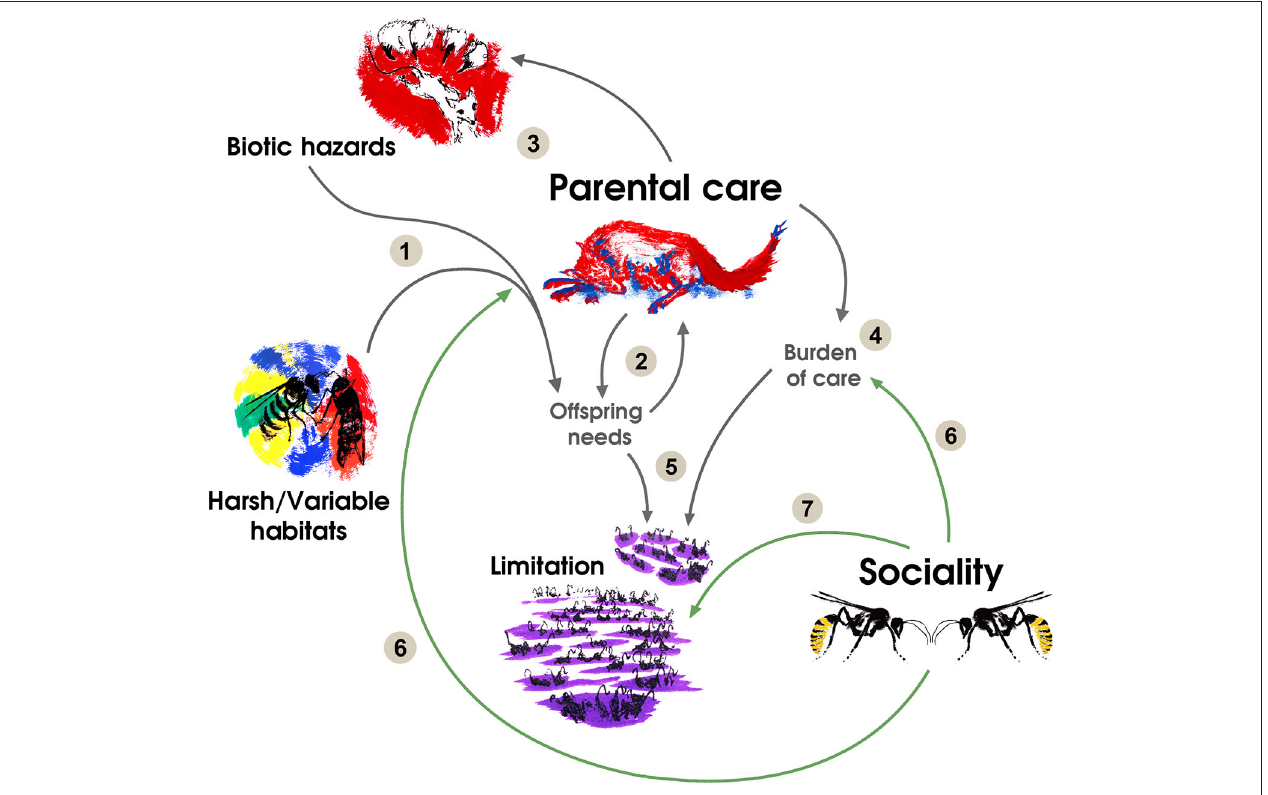
FIGURE 1 | The relationships between the evolution of parental care, environmental factors and social transitions can be summarized as follows: (1) Habitats or biotic hazards affecting offspring survival increase offspring needs. (2) This increase in offspring needs selects for parental care and generates a first positive feedback loop due to coevolution between offspring altriciality and care behaviors. (3) Predators and parasites coevolve with parental care in a second positive feedback loop selecting for more care. (4) Increases in care result in a higher burden per reproductive bout. (5) More sophisticated needs of offspring and a higher burden of care result in a lower carrying capacity and may result in limitation of breeding possibilities. (6) Sociality is heavily selected in species under processes (1, 2, 3, and 4) because it reduces the burden of care through mutualism or cooperative behaviors and reduces the impact of environmental pressures on offspring development and survival. (7) Sociality is selected in species under previous processes because it allows reducing limitation through sharing a reproductive resource, such as a suitable nesting place. In species with reproductive skew, social queuing for the breeding position is selected under limitated possibilities for solitary breeding resulting from processes (1, 2, 3, and 4). Drawings by